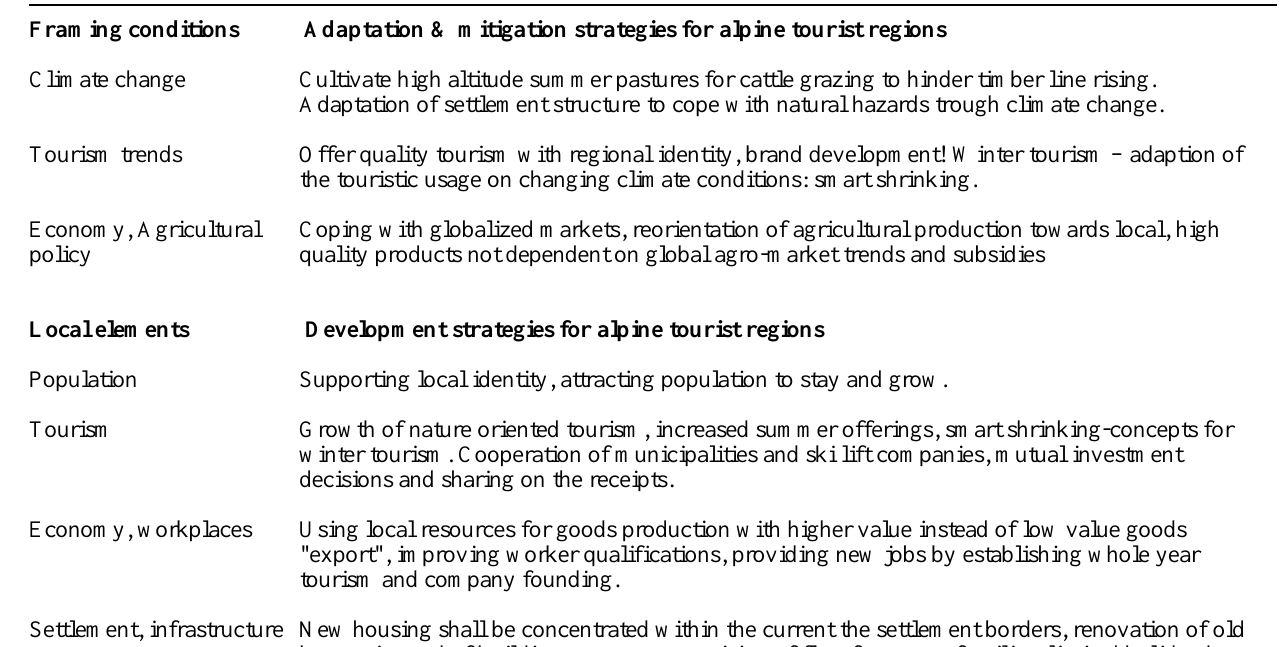
Table 2 . Generic strategies for Alpine tourist regions derived from strategy discussions with local